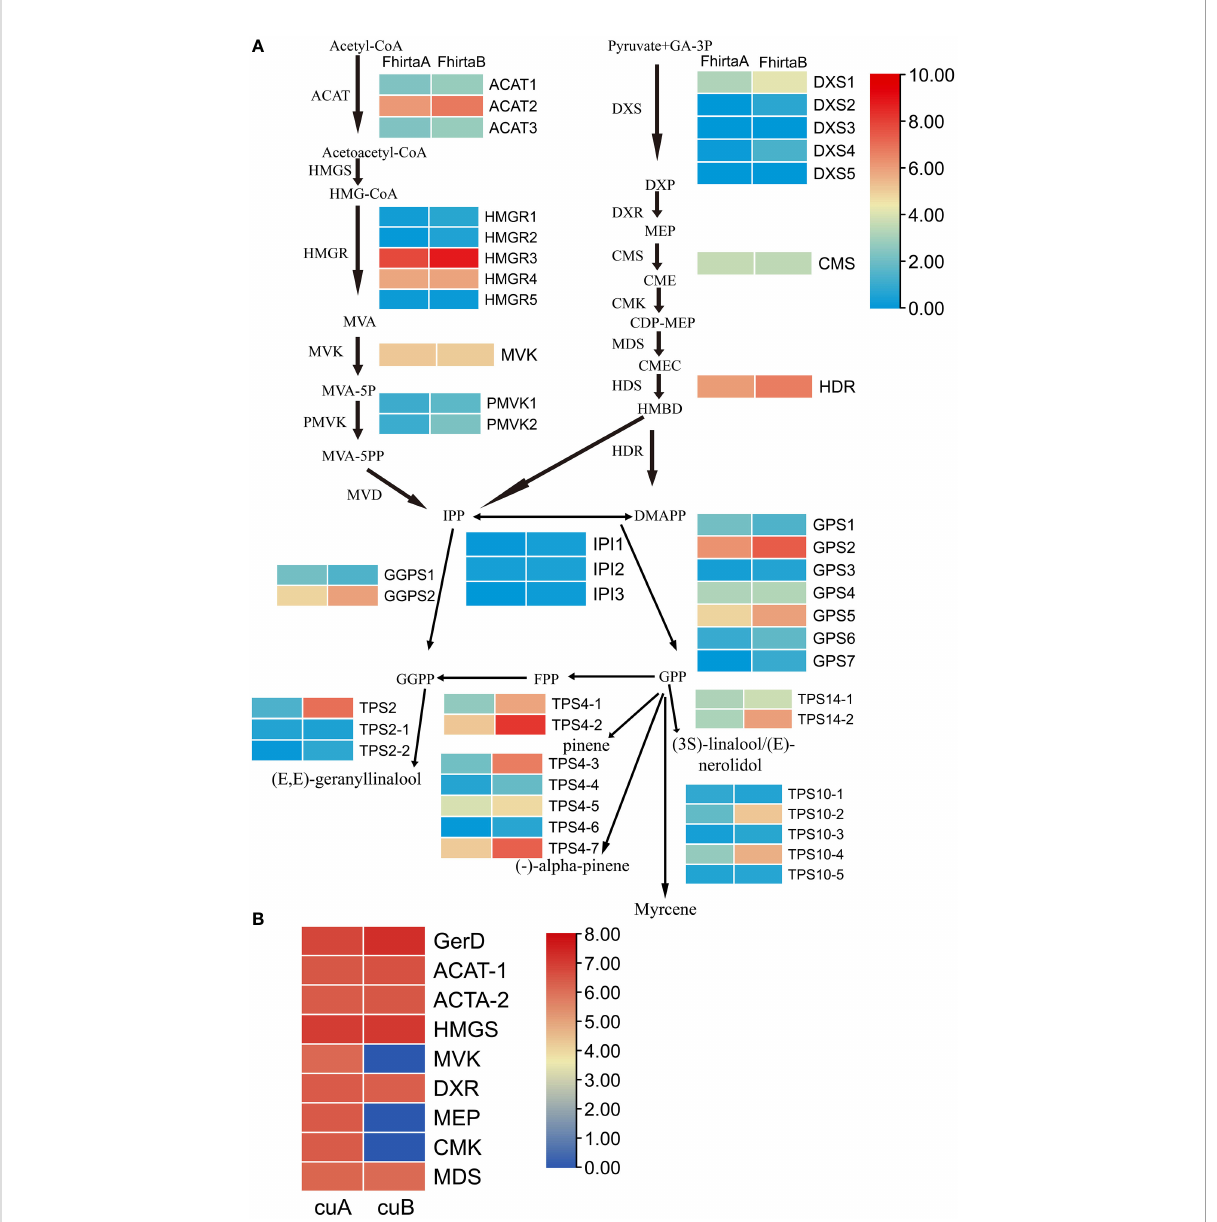
FIGURE 6 Expression pro fi les of genes and proteins involved in the terpenoid synthesis pathway of F hirta . (A) Expression levels for genes in A- and B- phase of F hirta bracts were shown by heatmap according to log 2 (FPKM). (B) Expression levels for proteins in A- and B-phase of F hirta bracts were shown by heatmap according to log 10 (Protein Abundance). CuA and CuB represent A phase and B phase of F hirta bracts,